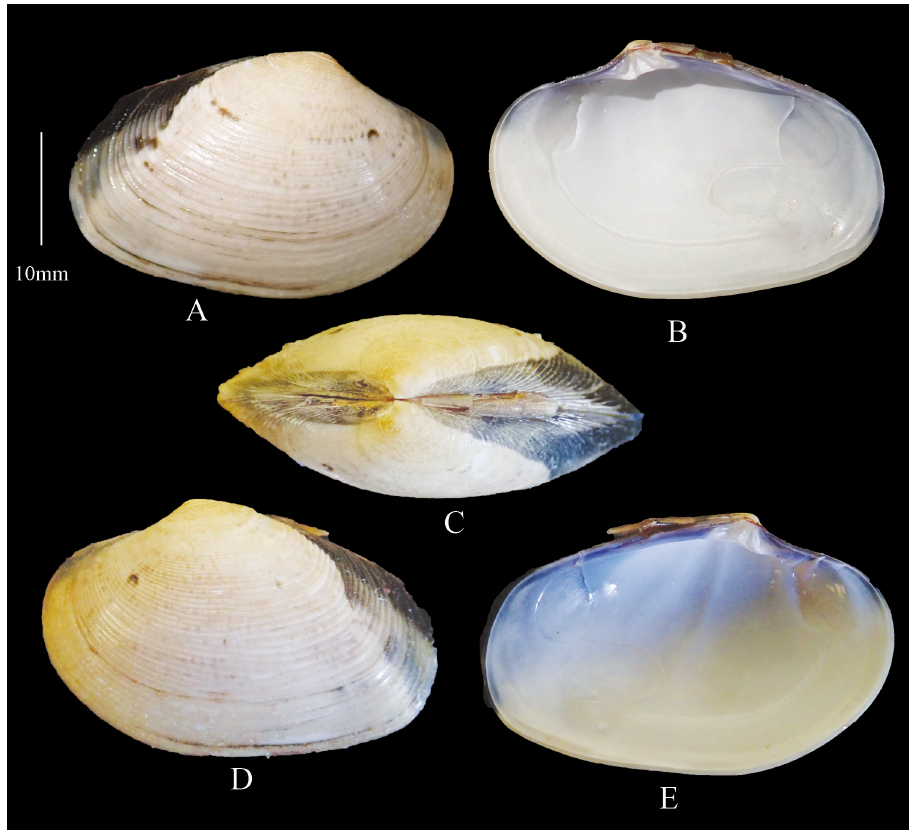
Figure 8. Marcia recens Morphotype 4 A right valve dorsal B right valve ventral C dorsal margin D left valve dorsal E left valve ventral (DABFUK), Ashtamudi Lake,